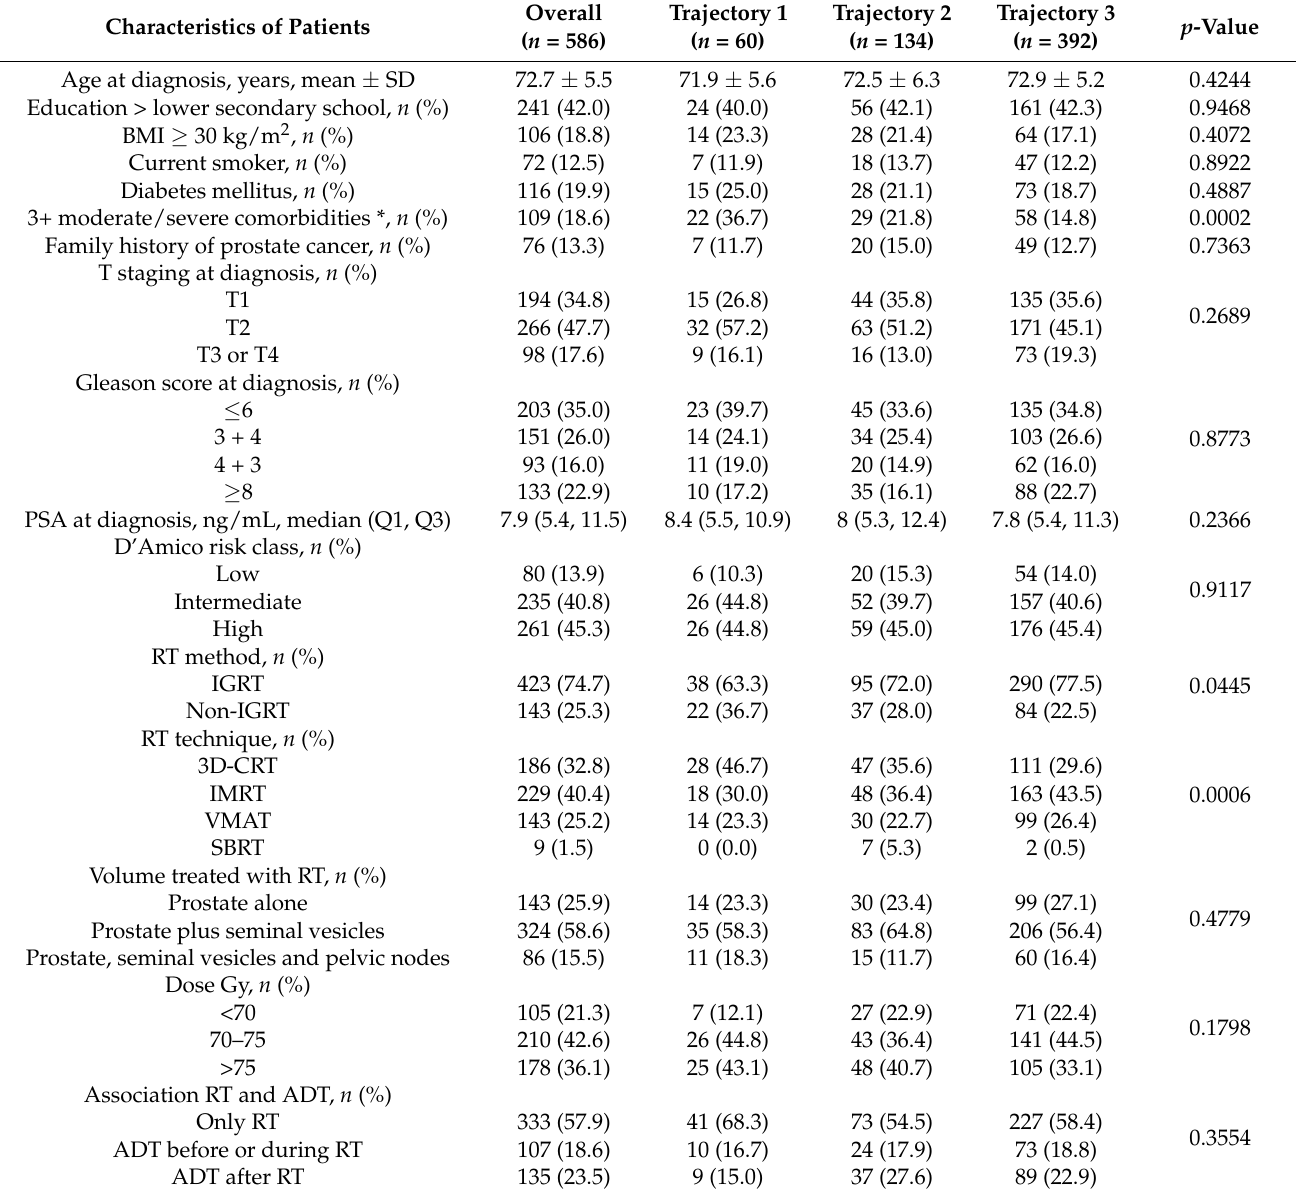
Table 1. Characteristics of patients according to trajectories identified for bowel function (BF). Characteristics of Patients